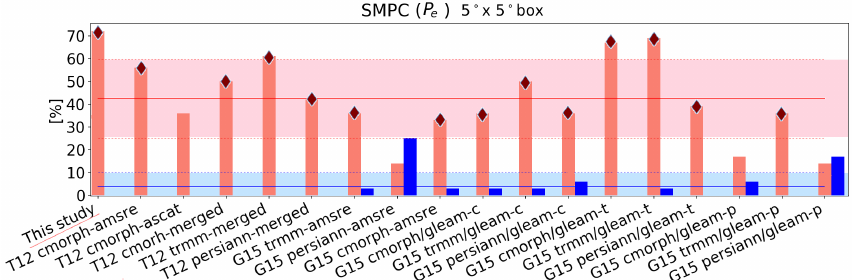
Figure 5. Percentage of 5 ◦ × 5 ◦ grid boxes with significantly negative ( P e < 10%, in red) and positive ( P e > 90%, in blue) spatial SMPC over the North African domain in this study and previous studies of T12 and G15. Different data set combinations used in T12 and G15 are listed. Mean and SD of the negative (positive) SMPC fractions across the experiments are shown as a red (blue) solid line and shading accordingly. Following visual inspection, the experiments, in which a significant negative SMPC relationship exists in the western region of the North African domain, are marked with a